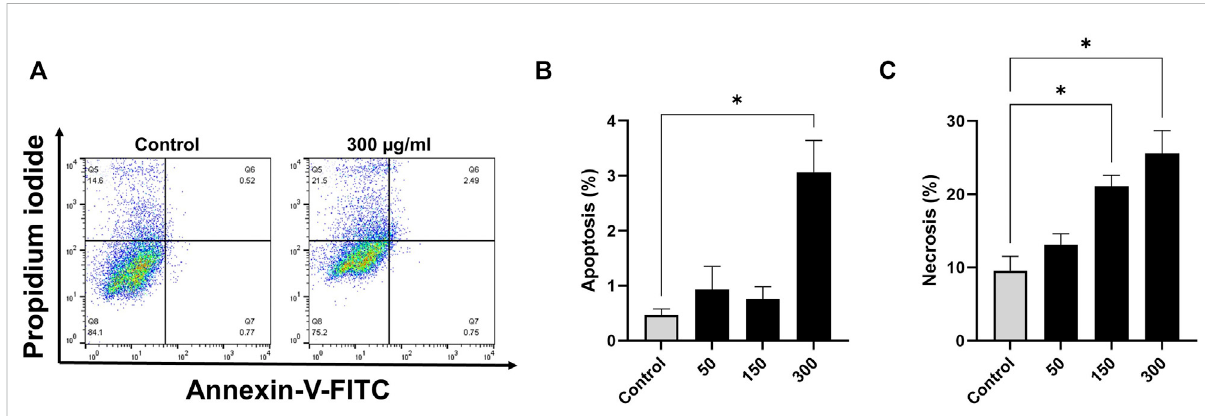
FIGURE 2 Flow cytometry analysis of MCF-7 cells following the treatment with various concentrations of ethanolic extracts of C. comosum . MCF-7 cells weretreated with EECC 50, 150 or300 μ g/ml for 48 h. Apoptosis and necrosis were detected byuse of FACS Annexin V and PIstaining. * p < 0.05 vs. control. Data represent mean ± SD of triplicates.